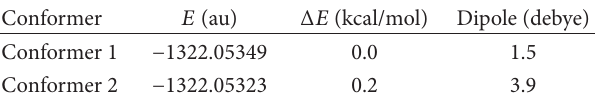
T 1: Energies B3LYP/6-31G(d,p) of the different conformations of the title compound.